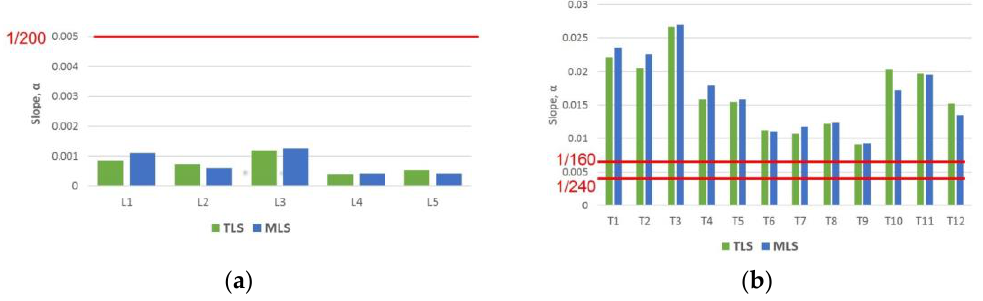
Figure 24. Angular distortion for the textured MSE wall face at Site-1: ( a ) longitudinal angular distortion along lines L1–L5, and ( b ) transversal angular distortion along lines T1-T12 (the horizontal lines represent the tolerable angular distortions)—L1–L5 and T1–T12 are illustrated in Figure 17. Table 6. TLS-based and MLS-based panel parametrization for the textured MSE wall at Site-1. TLS-Based Measures